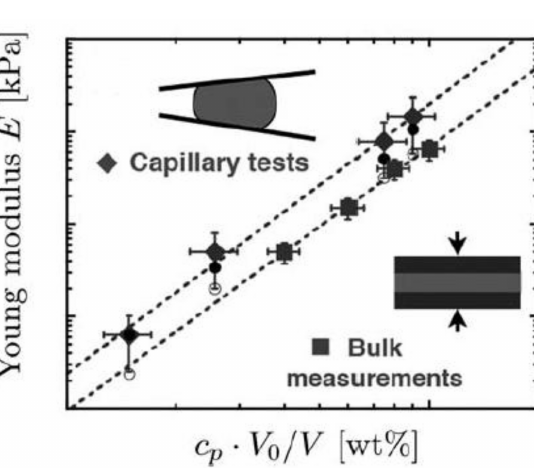
Figure 6. Young’s modulus E from compressive mechanical tests on bulk polyacrylamide gels (squares) and for microgel particles (diamonds) as derived from the compressive modulus K (solid circles) and the shear modulus G (open circles). To account for the swelling of the particles in water, the polymer concentration c p is corrected by the volume ratio V 0/ V ( V 0 is the initial volume of the particles as they are formed in oil and V is the equilibrium volume of the collected particles in water). (H. M. Wyss et al., Copyright 2010 Royal Society of